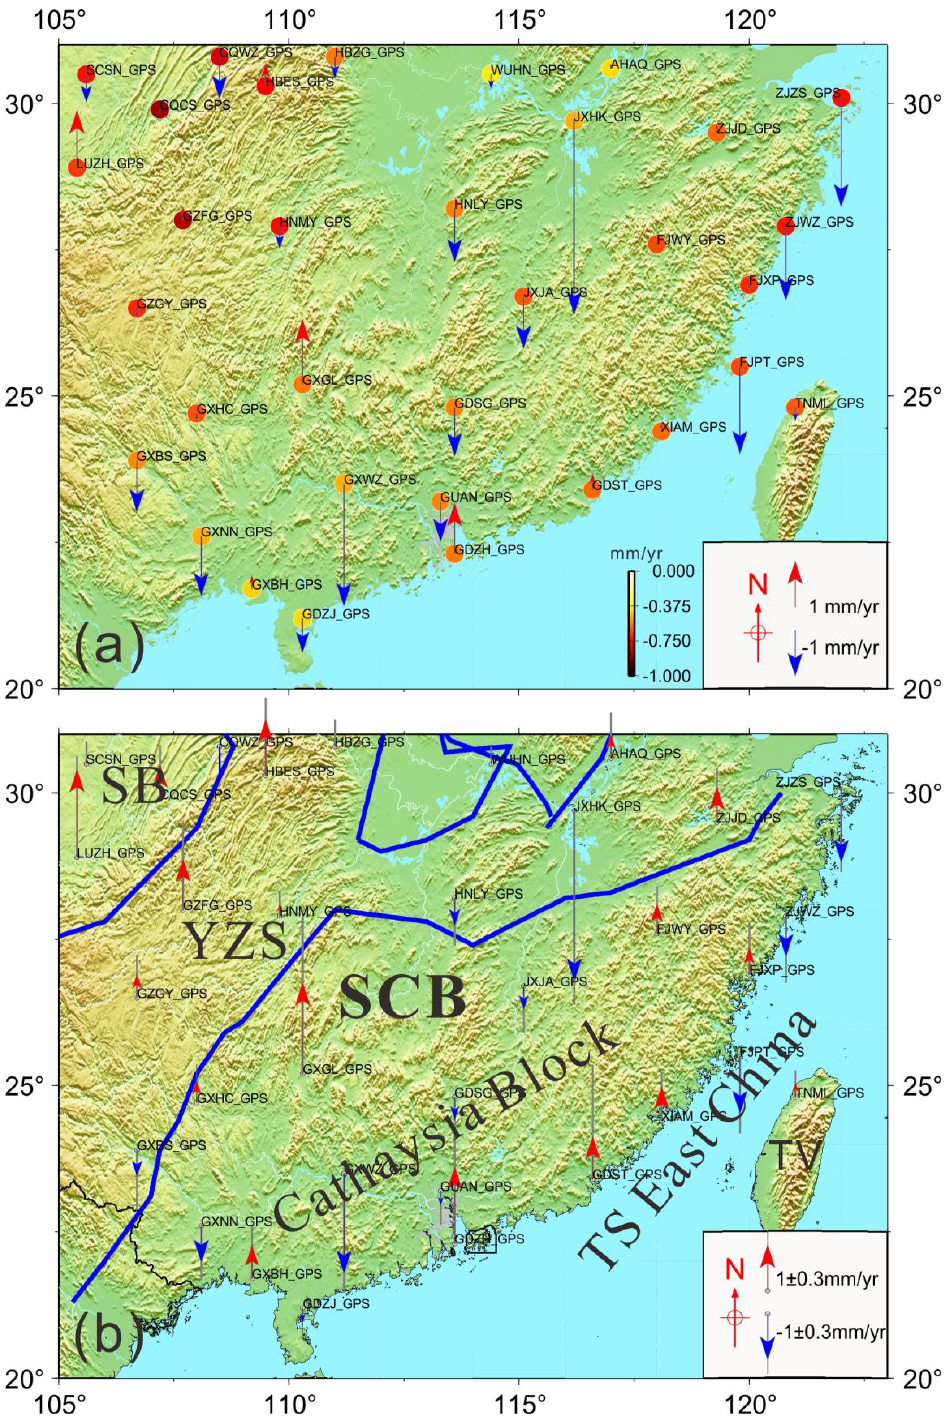
Figure 7. ( a ) The GRACE-RL5 was used to estimate the gravity in Southern China, spanning from April 2002 to January 2016. The dots denote the vertical deformations caused by surface loads corresponding to the GPS sites location. The vertical vectors are GPS-derived raw vertical rates; ( b ) Vertical crustal tectonic movement of SCB with the loading effects removed (by using GPS-derived rates to subtract GRACE-model loads). Red vectors denote subsidence uplift, and blue vectors denote subsidence. The gray lines behind arrows are the uncertainty of all sites. The blue boundary lines are tectonic lines in the South China Block. SB: Sichuan Basin; YZS: Yangtze Craton; SCB: South China Block; TS: Taiwan